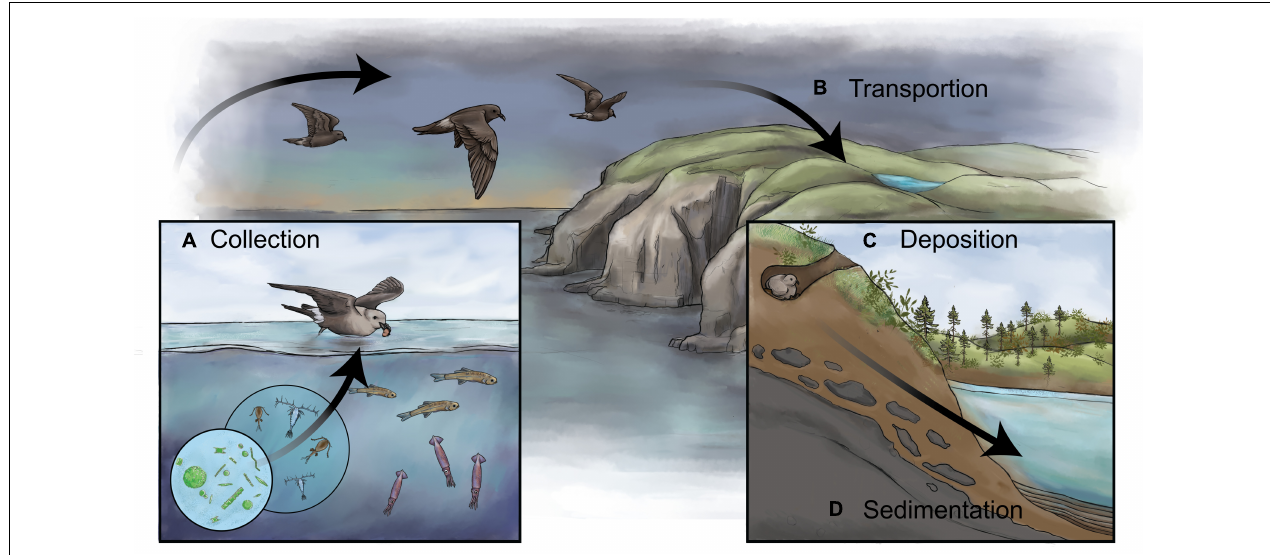
FIGURE 1 | A schematic showing how biovectors can influence inland bodies of water and how sediments can be used to reconstruct past colony dynamics. (A) Biovectors, in this case storm-petrels, typically occupy a high-trophic level and are gregarious on land. When feeding in the open ocean, they collect and concentrate marine nutrients (i.e., N, P) and other products, including stable isotopes (e.g., δ 15 N), bio-elements (e.g., Cd, Zn, Hg), and contaminants. (B) Biovectors transport these nutrients and other products from their feeding grounds to terrestrial breeding colonies. (C) The nutrients and other products are deposited in high concentrations onto the landscape via wastes in the forms of feces, dropped or regurgitated food, eggshells, feathers, and carcasses. (D) In the presence of a receiving body of water, such as a lake or pond, the waste products alter the water chemistry and, subsequently, the biotic assemblages, which are then archived in a waterbody’s sediments, thus creating a continuous long-term record of changes in the colony size. By retrieving a dated sediment core from the biovector-influenced pond and analyzing it for paleolimnological proxies, it is possible to reconstruct changes in past colony